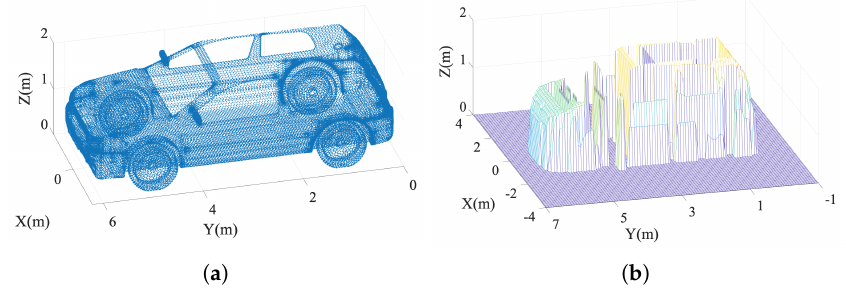
Figure 8. Car model used in experiment. ( a ) Geometric model. ( b ) Scattering coefficient